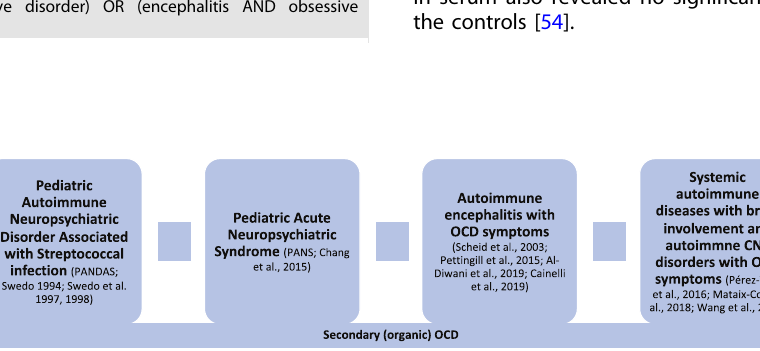
Fig. 1 Autoimmune mediated secondary (organic) obsessive-compulsive syndromes [27 – 29, 34, 38 – 41, 44, 47, 48]. Abbreviations: CNS, central nervous system; OCD, obsessive-compulsive